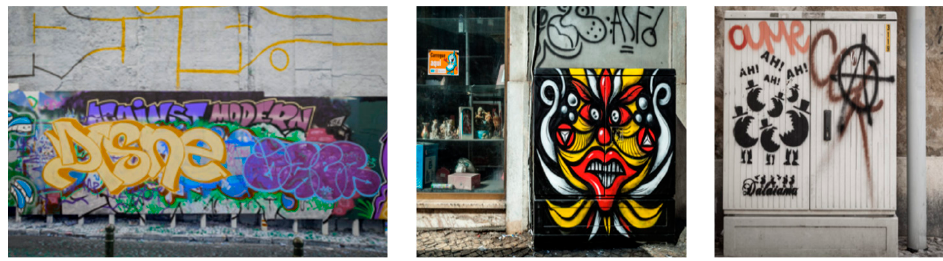
Figure 16. Misclassified graffiti due to similarities between the two classes ( left ) and due to images